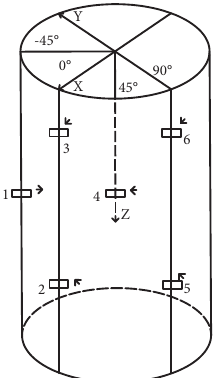
Figure 1: Schematic diagram of the arrangement of strain gauges on the core surface.